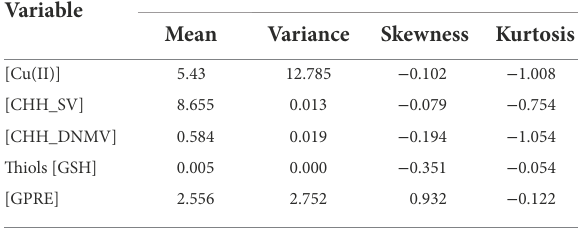
TABLE 2 Descriptive statistics of the variables present in the postulated